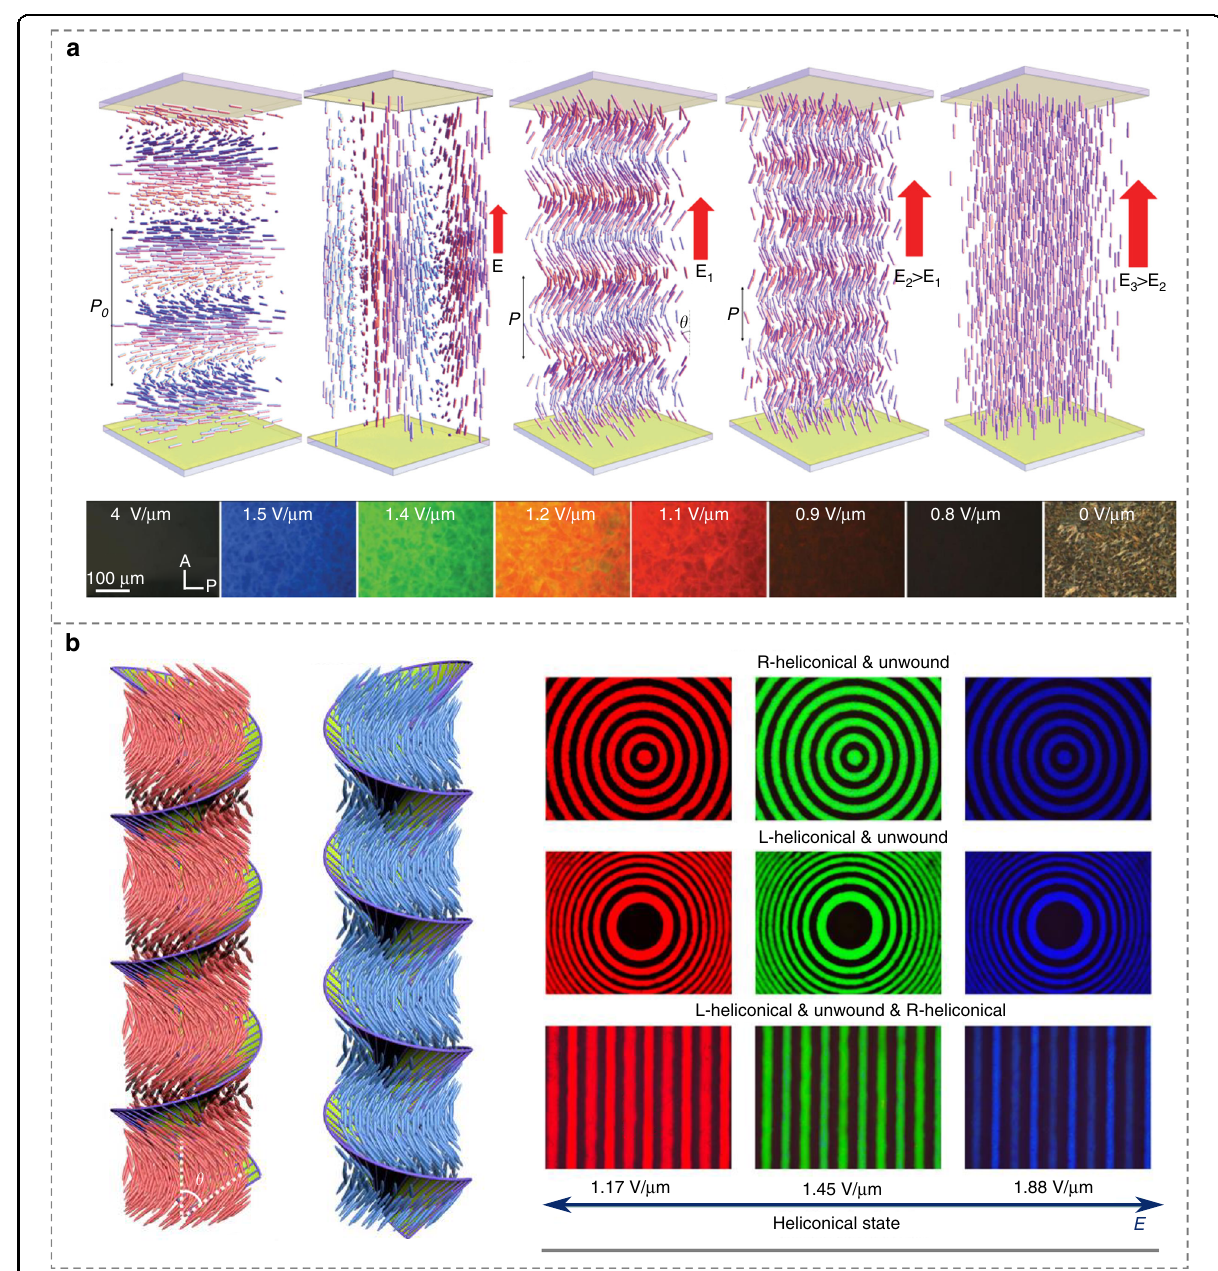
Fig. 7 Dynamic tuning of oblique helicoidal architectures in CLCs. a Field-controlled oblique helicoidal CLC structure 38 . Reproduced from ref. 38 , with permission from Wiley-VCH. b Electrically stimulated transformation of CLC superstructures 130 . Adapted from ref. 130 , with permission from